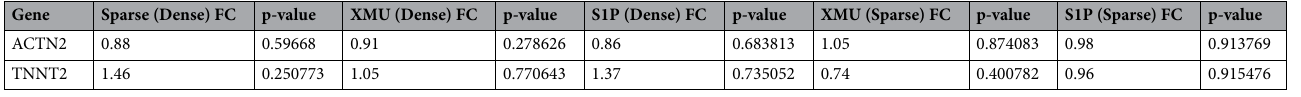
Table 3. Cardiomyocyte-specific genes.